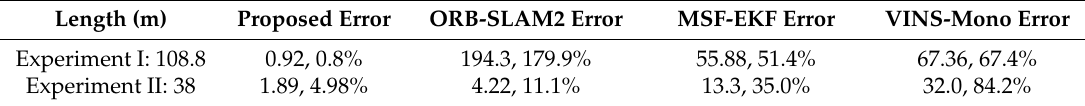
Table 3. Length accuracy (m).